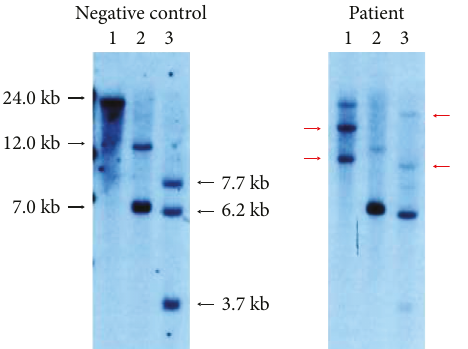
Figure 5: Southern blot analysis of HTLV-1 provirus DNA depicted two bands (red arrows) in after BamH-I digestion and two bands (red arrows) after Hind III digestion. 1: BamH-I; 2: EcoR-V; 3: Hind III.